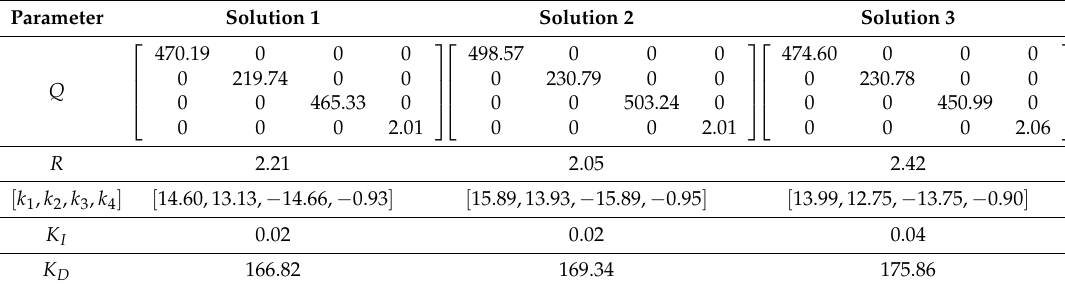
Table 2. Performance of three solutions.